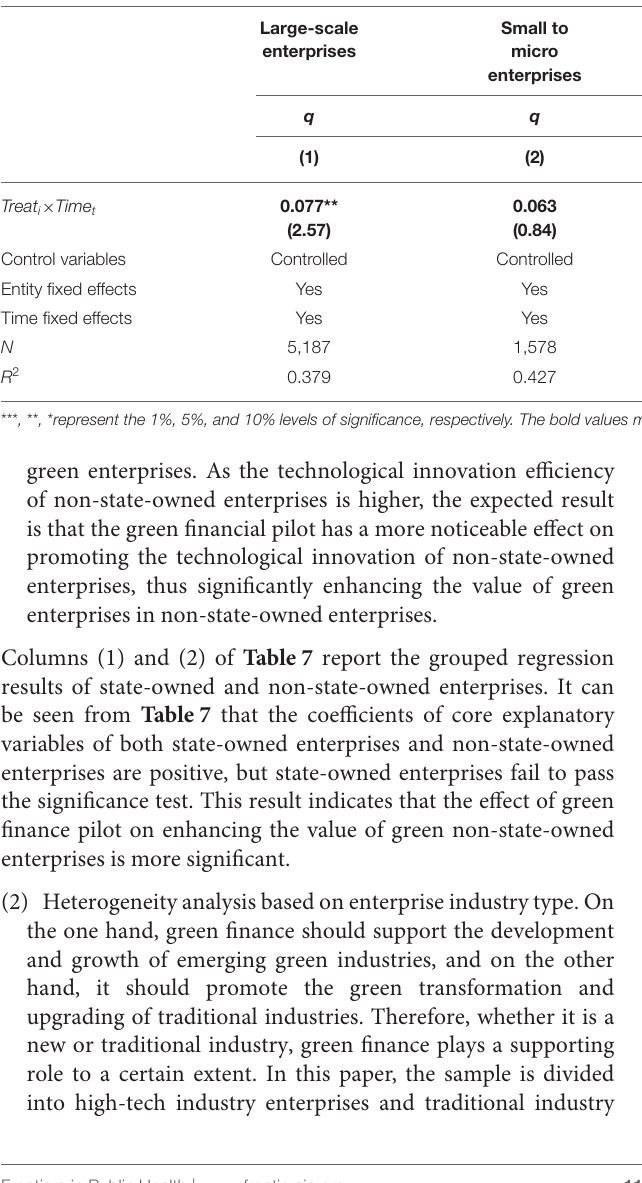
TABLE 8 | Heterogeneity analysis results